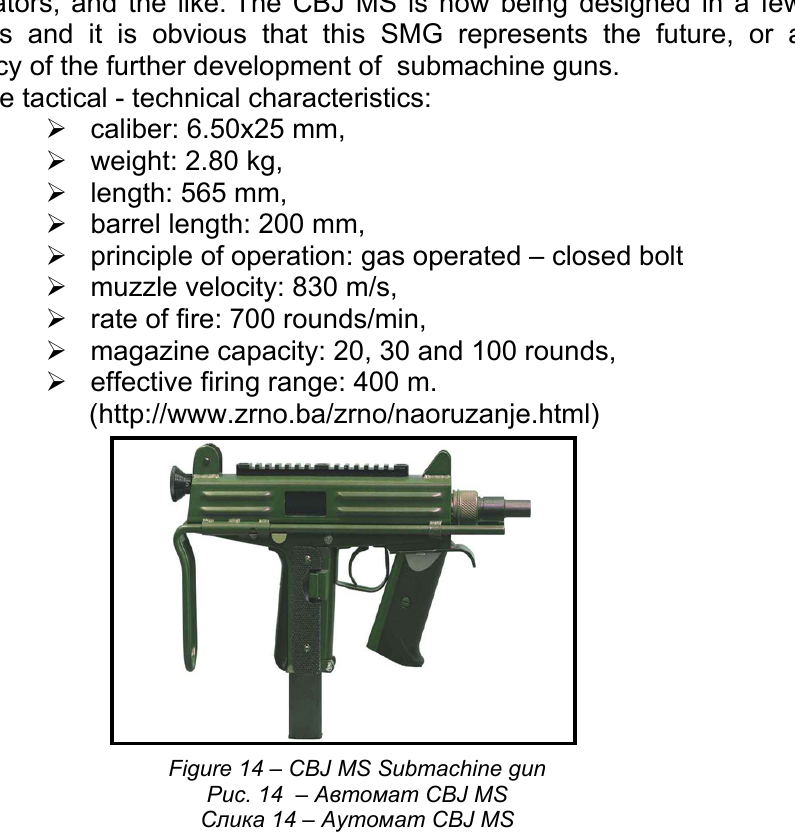
Figure 14 – CBJ MS Submachine gun Рис . 14 – Автомат CBJ MS Слика 14 – Аутомат CBJ